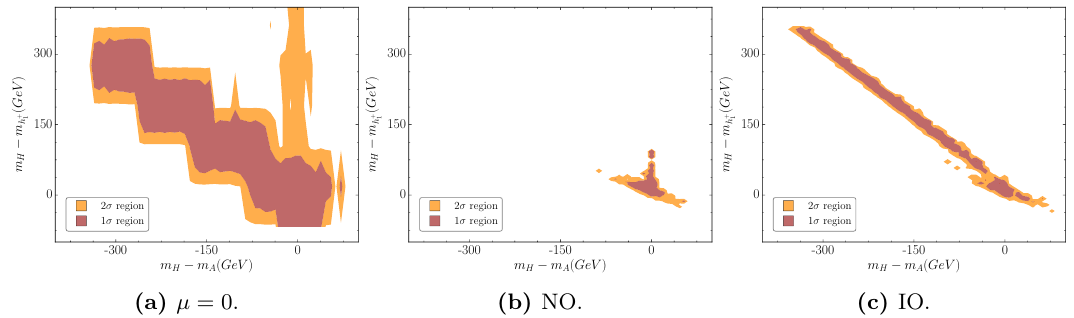
Figure 9. Splittings of the scalar masses: allowed regions of the mass di(cid:11)erences m H m H m for (a) (cid:22) = 0, (b) NO, and (c) h + 1 (cid:0)